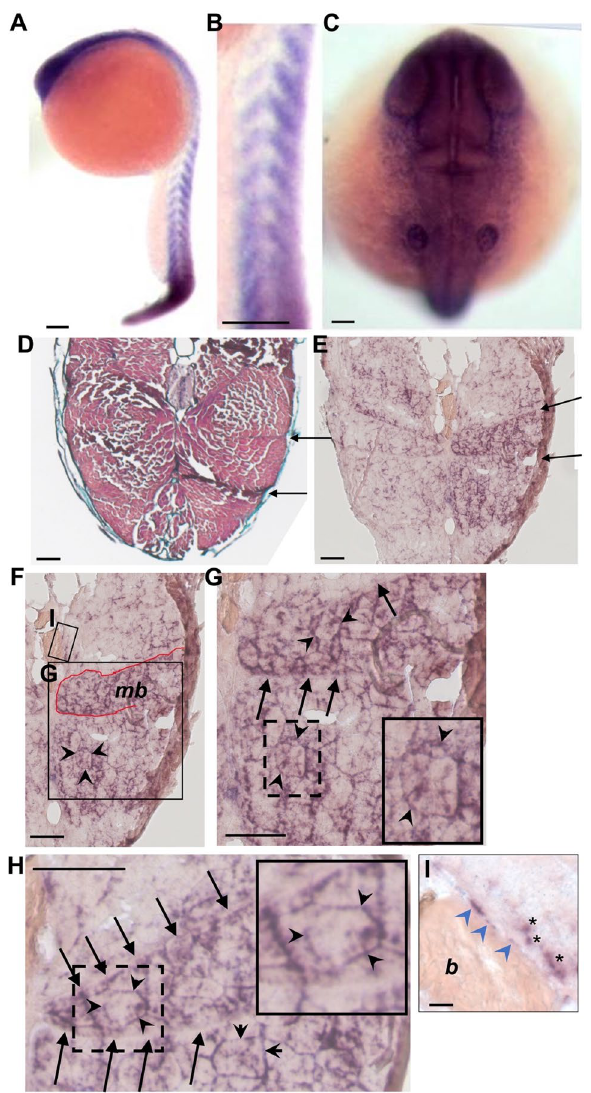
Figure 2. Expression of ppp2r3b in zebrafish. ( A–C ) In situ hybridisation showing expression of ppp2r3b at 24 hpf. High-power view showing expression in somites ( B ) and rostally ( C ). ( D ) Transverse section of 36 dpf zebrafish stained with Mallory’s trichrome. Arrows indicate examples of myosepta separating bundles of muscles fibres. ( E ) Similar section to ( D ) showing expression of ppp2r3b at 36 dpf. Arrows indicate myosepta that define muscle bundles outlined in red ( mb, F ). ( G , H ) Higher magnification images whereby arrows indicate myosepta, and arrowheads indicate staining around individual muscle fibres. Dashed boxes show the location of the insets which individual muscle fibres at higher magnification. ( I ) Inset from F showing mineralised bone ( b ) within vertebral centra showing expression of ppp2r3b in squamous chordoblast cells (arrowheads). Asterisks label individually staining cells of distinct morphology. Scale bars are 200 µm in ( A , B ); 40 µm in ( C ); 150 µm in ( D – H ); 12 µm in ( I